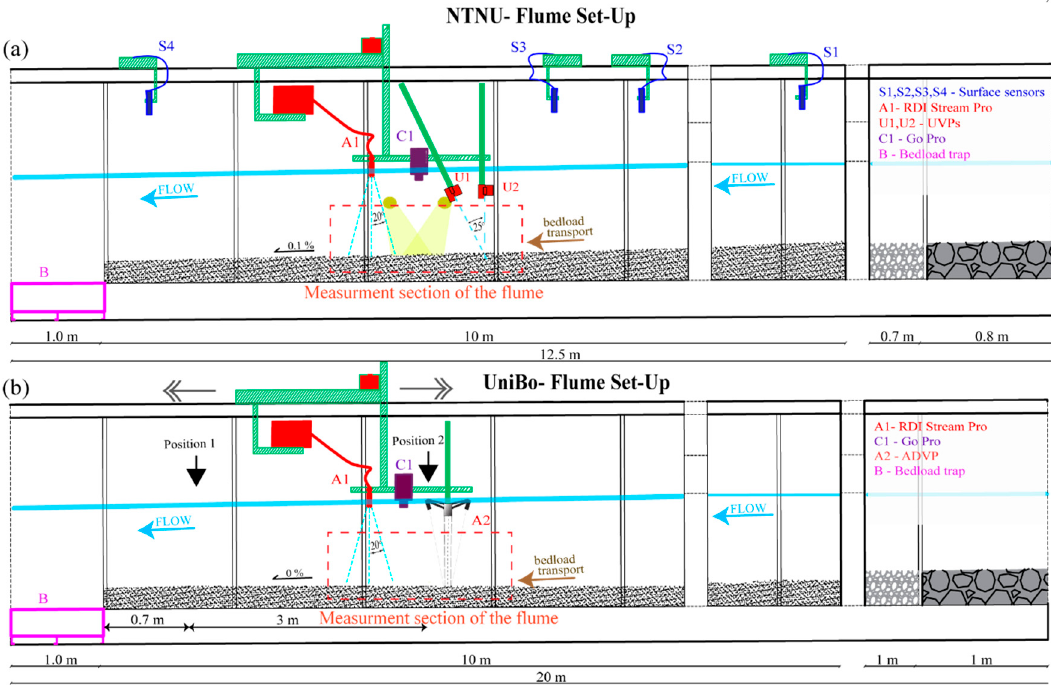
Figure 1. Experimental set-up. ( a ) Norwegian University of Science and Technology (NTNU—ultrasound velocity profiler (UVP)/acoustic current Doppler profiler (ADCP), medium sand, set-up; ( b ) UniBo ADVP/ADCP set-up, coarse sand.